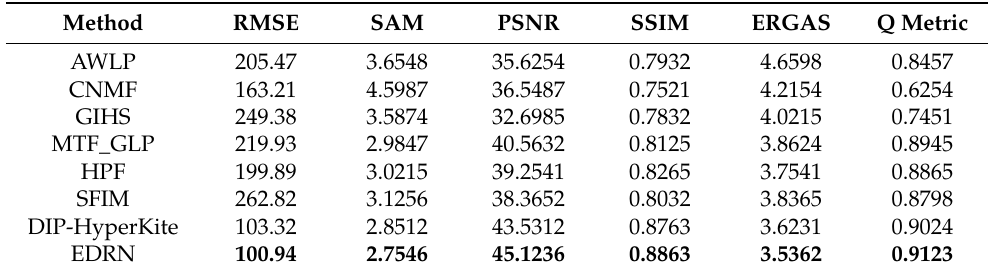
Table 7. Time cost (second) for taking different input for up-sampling. Time Cost (Second) Baiyangdian Chaohu Dianchi Entire HSI 37.61 36.79 37.23 One image patch 0.109 0.115 0.114 Image patch for total 27.795 29.325